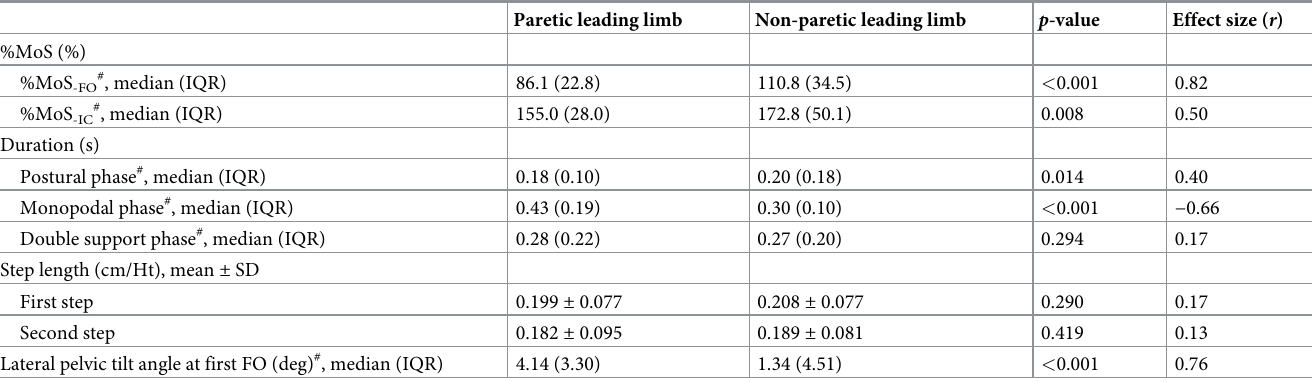
Table 2. Differences between use of the paretic and non-paretic leg as the leading limb (N = 38). Paretic leading limb Non-paretic leading limb p -value Effect size ( r